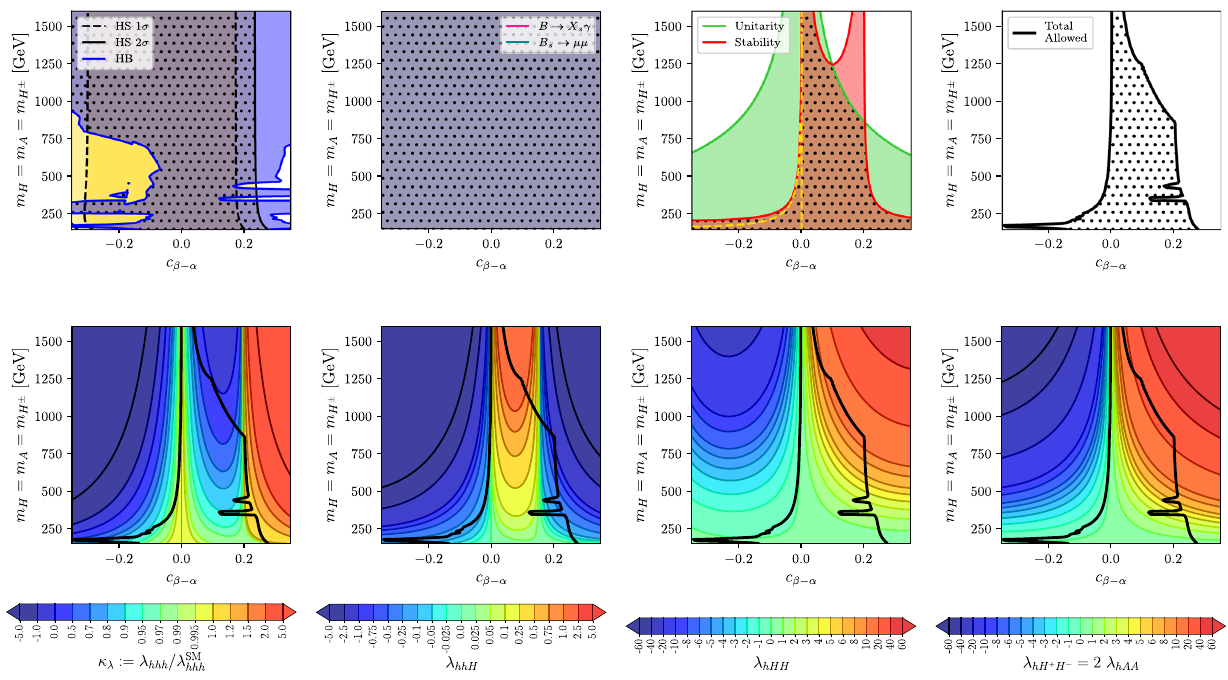
Fig. 6 Allowed areas (dotted regions) from the various constraints (upper row) and triple Higgs couplings (lower row) for the benchmark scenario I-3 in the c β − α – m plane with tan β = 10 and m 2 fixed via Eq. (6) 12